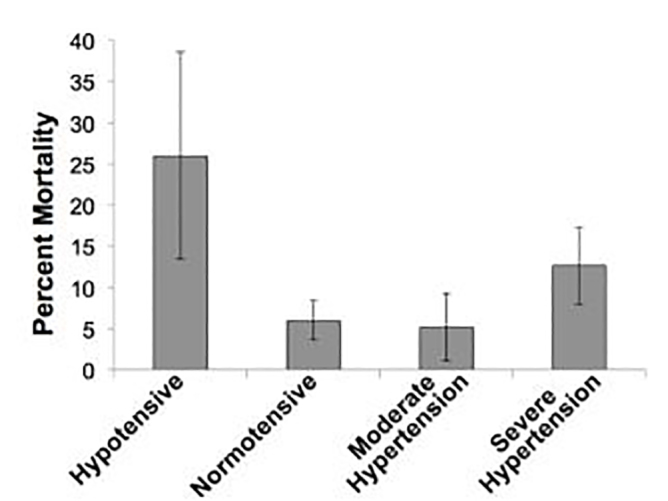
24-hour mortality by blood pressure category (%, 95CI).